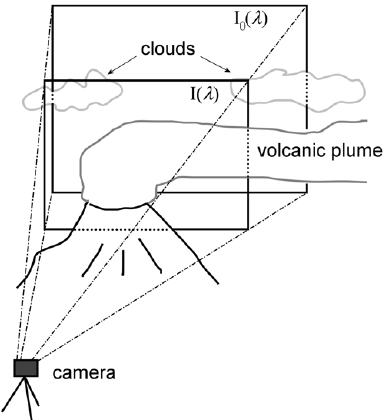
Fig. 2. Schematic of the SO 2 camera measurement geometry. The Figure 2. Schematic of the SO 2 camera measurement geometry. The intensity of incident 7 intensity of incident radiation I(λ) is measured in and around the radiation I ( λ ) is measured in and around the volcanic plume. In order to calculate the SO 2 8 volcanic plume. In order to calculate the SO 2 optical density τ ( λ) optical density τ ( λ ) from which the SO 2 column density is derived, however, information 9 from which the SO 2 column density is derived, however, informa- about the background intensity I 0 ( λ ) is needed (see Equation (4)). This information can be 10 tion about the background intensity I 0 (λ) is needed (see Eq. 4). This information can be difficult to obtain, especially if the illumi- difficult to obtain, especially if the illumination conditions behind the plume are 11 nation conditions behind the plume are inhomogeneous e.g. due to inhomogeneous e.g. due to the presence of clouds. 12 the presence of